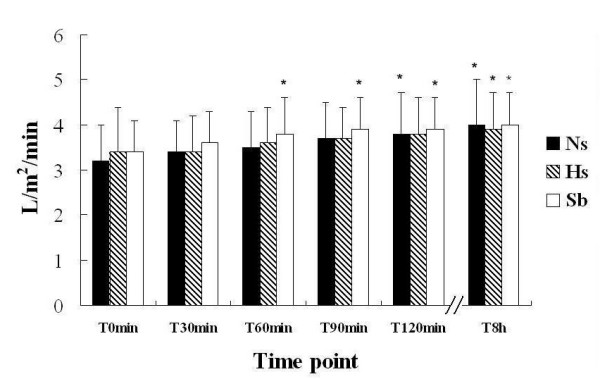
Effects of fluid resuscitation on CO in the three groups. The trial program and case grouping were carried out according to the design indicated in Methods. CO was measured by Doppler echocardiography. There were no differences in CO among the three groups at all the six time points. Comparing the CO variables in the same group, CO at T120 and T8h was significantly higher than at T0 in the Ns group; the parameter at T8h was higher than at T0 in the Hs group; and CO at T60, T90, T120 and T8h were higher than that at T0 in the Sb group (*p < 0.05). CO improved earlier in the Sb group than in the Ns and Hs groups.